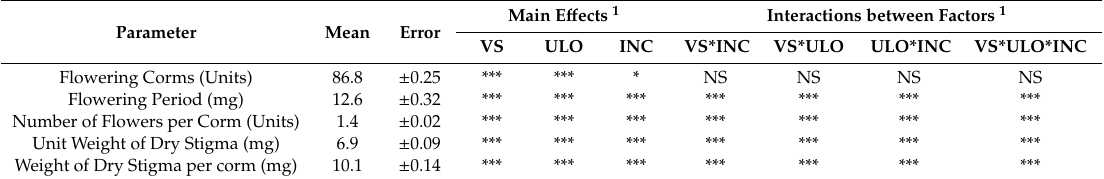
Table 2. Mean value of the parameters analysed and level of significant di ff erences for the studied factors and their interactions, season